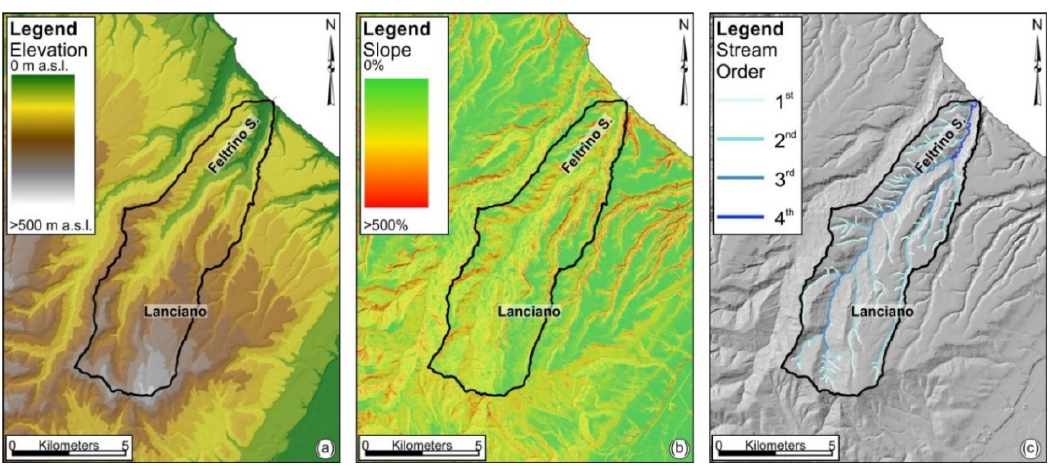
Figure 3. Orographic and hydrographic maps: ( a ) Elevation map; ( b ) slope map; ( c ) stream order map. Black line: The Feltrino Stream basin.